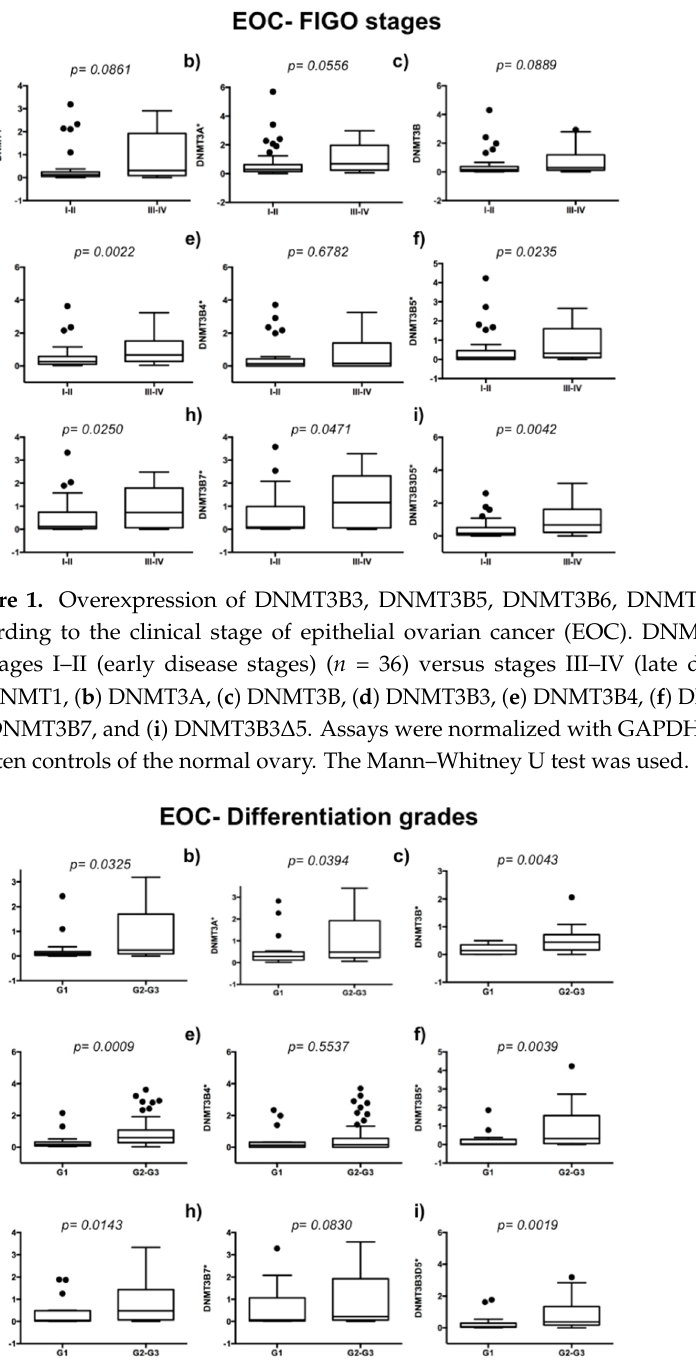
Figure 2. Expression of DNMT1, DNMT3A, DNMT3B3, DNMT3B5, DNMT3B6, and DNMT3B3 Δ 5 according to histological grade. DNMTs’ expression in low-grade (n = 13) versus high-grade (n =